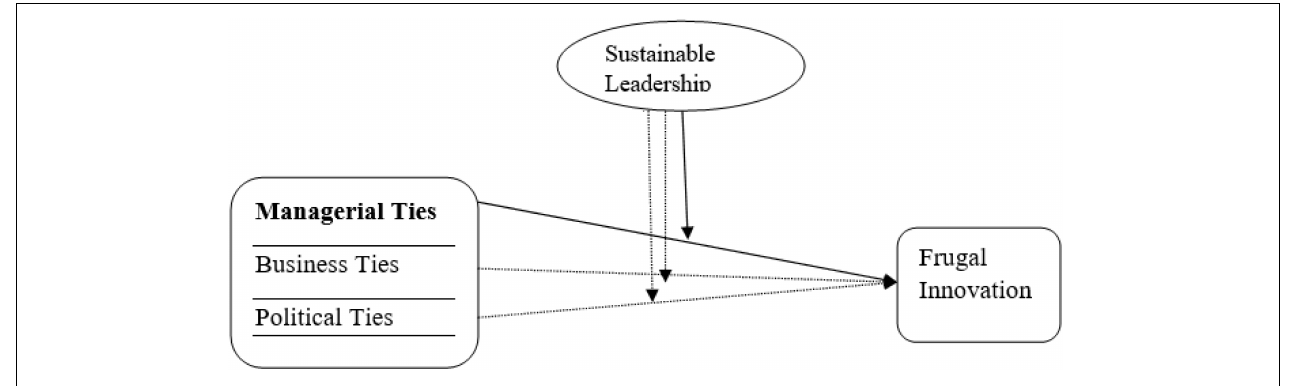
FIGURE 1 | Research